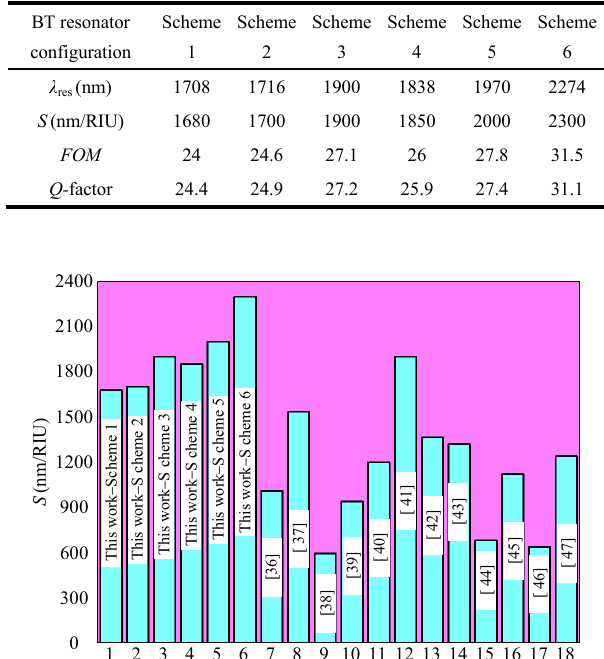
Table 3 Spectral characteristics of proposed sensor designs based on the BT configuration.